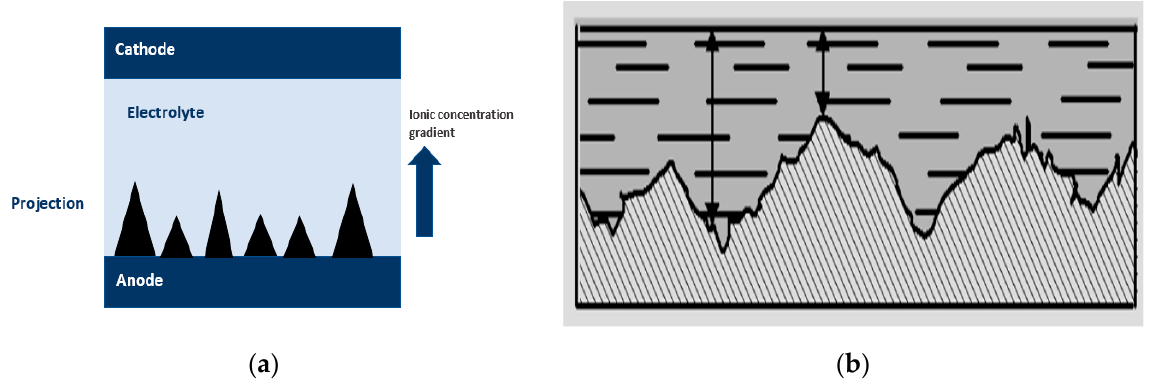
Figure 10. ( a ) The ionic gradient formed when anode (workpiece) and cathode are immersed in electrolyte [70] (after Yang 2017 [70]), ( b ) The variations in current intensity at the peak ( I P ) and recess ( I r ) areas of anode.